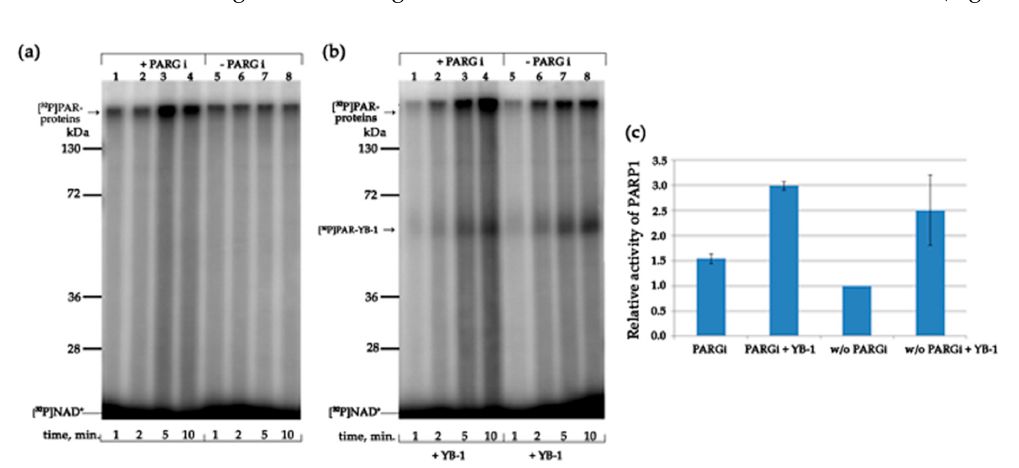
Figure 11. YB-1 affects the PARylation reactions catalysed by proteins of nuclear extracts from HeLa cells. ( a , b ) Protein PARylation in the presence of HeLa nuclear extracts and [ 32 P]NAD according to SDS-PAGE and phosphor imaging. The reaction mixtures consisted of 1.0 mg / mL nuclear extract proteins, 0.25 OD 260 /mL activated DNA, 5 mM MgCl 2 , 4 µM NAD + and [ 32 P]NAD (0.4 µCi), 1600 nM YB-1 ( b ), and either 1 µM PARG inhibitor (( a , b ), lanes 1–4) or no such inhibitor (( a , b ) lanes 5–8), as